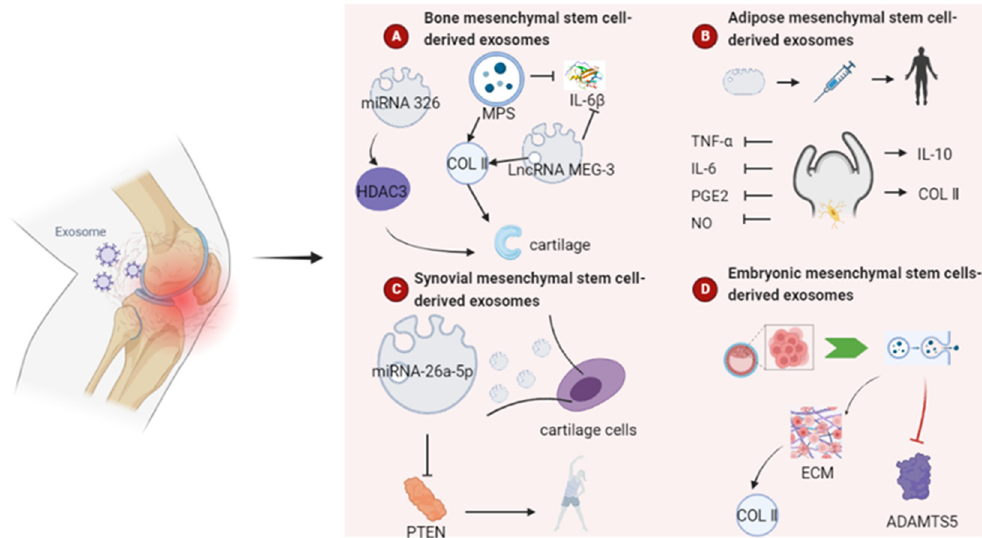
Figure 5. Role of exosomes as drug delivery systems for osteoarthritis. Exosomes derived from different mesenchymal stem cells can be used as DDS to treat osteoarthritis.